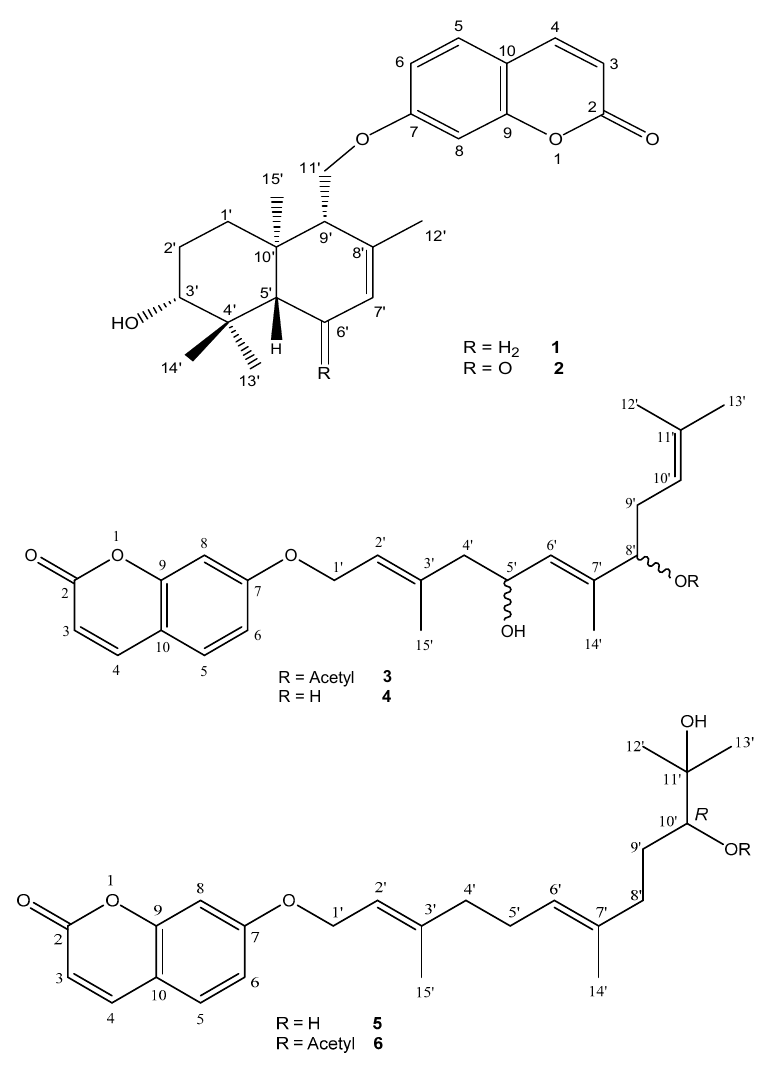
Figure 1. Structures of isolated constituents ( 1 – 6 ).